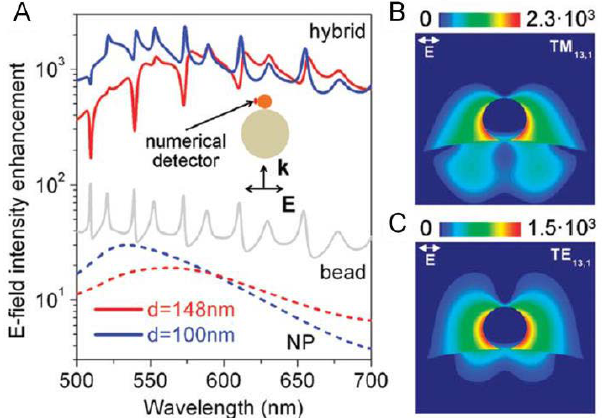
Figure 5: Near-field characterization of an optoplasmonic atom com- prising an Au nanoparticle separated from an OM by a 1 nm gap. The diameter of the PS microsphere is 2 µ m and the diameters of the Au nanoparticles are (red) 148 or (blue) 100 nm, as indicated. (A) E - field intensity enhancement in the gap between the Au nanoparticle and the OM. The location of the numerical director for evaluating the E -field intensity is indicated by a red dot in the inset. (B) and (C) Maps of the spatial E -field intensity enhancement around the Au nanoparticle at λ = 589.7 nm and λ = 614.4 nm. Reprinted with permission from Ahn et al. ACS Nano 6, 951 (2012). Copyright 2012 American Chemical